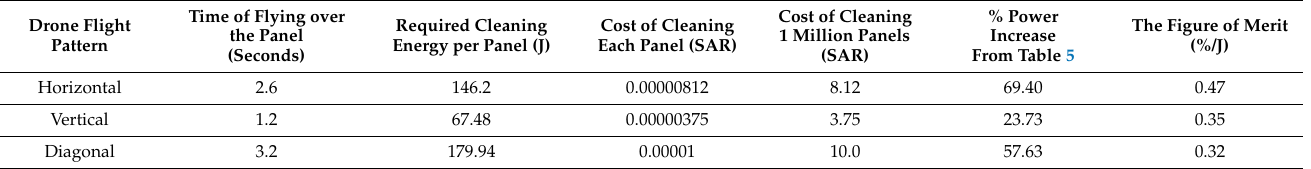
Table 8. Cost of power consumption for each drone flight pattern at 100 CC of dust